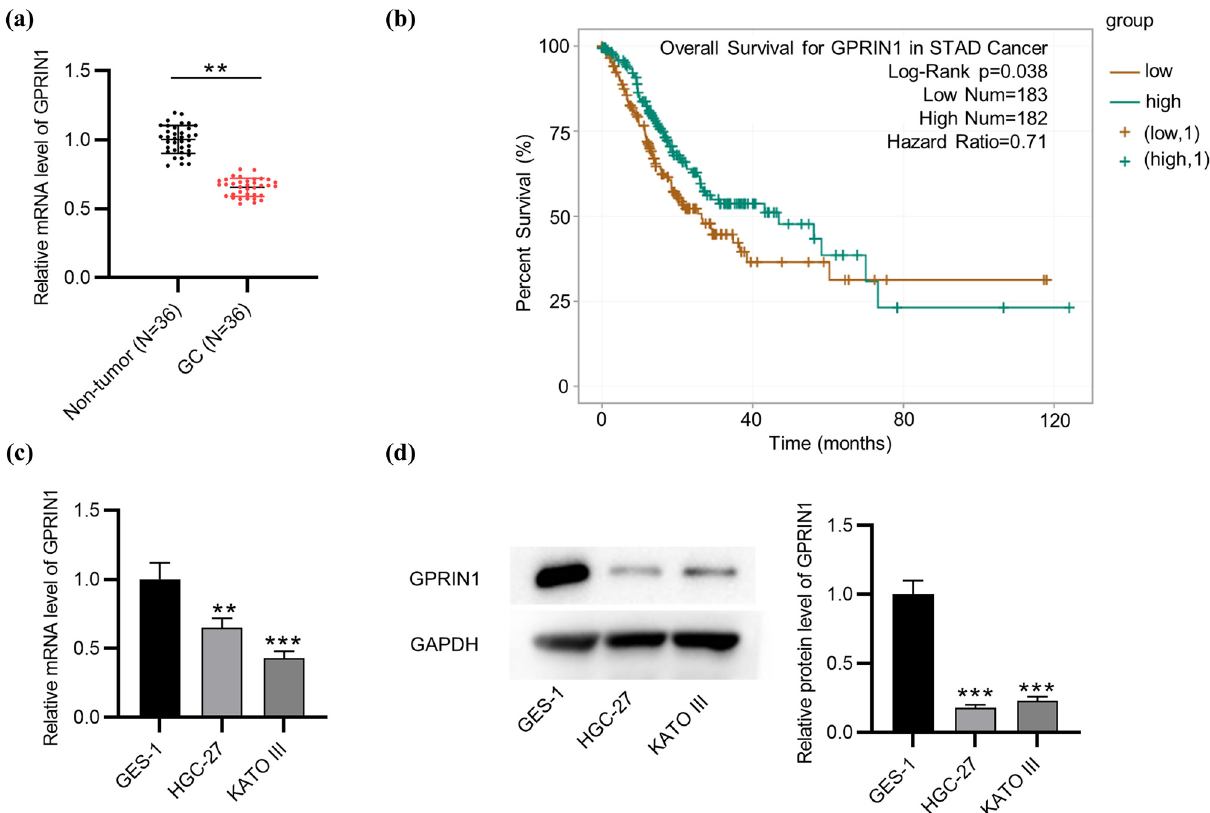
Figure 1: GPRIN1 is downregulated in GC cells and tissues. ( a ) Relative GPRIN1 mRNA expression level in 36 GC tissues compared to that in 36 normal gastric tissues was analyzed by RT - qPCR. ( b ) The relationship between GPRIN1 expression and overall survival of GC patients was predicted by starBase website ( http://starbase.sysu.edu.cn/ ) . ( c ) Relative GPRIN1 mRNA expression level in GC cell lines ( KATO III and HGC - 27 ) compared to that in a normal gastric epithelial cell line ( GES - 1 ) was evaluated through RT - qPCR. ( d ) GPRIN1 protein levels in GC cell lines ( KATO III and HGC - 27 ) and in a normal gastric epithelial cell line ( GES - 1 ) were detected by Western blotting, and the quantitative analysis was performed using ImageJ software. ** p < 0.01, *** p <